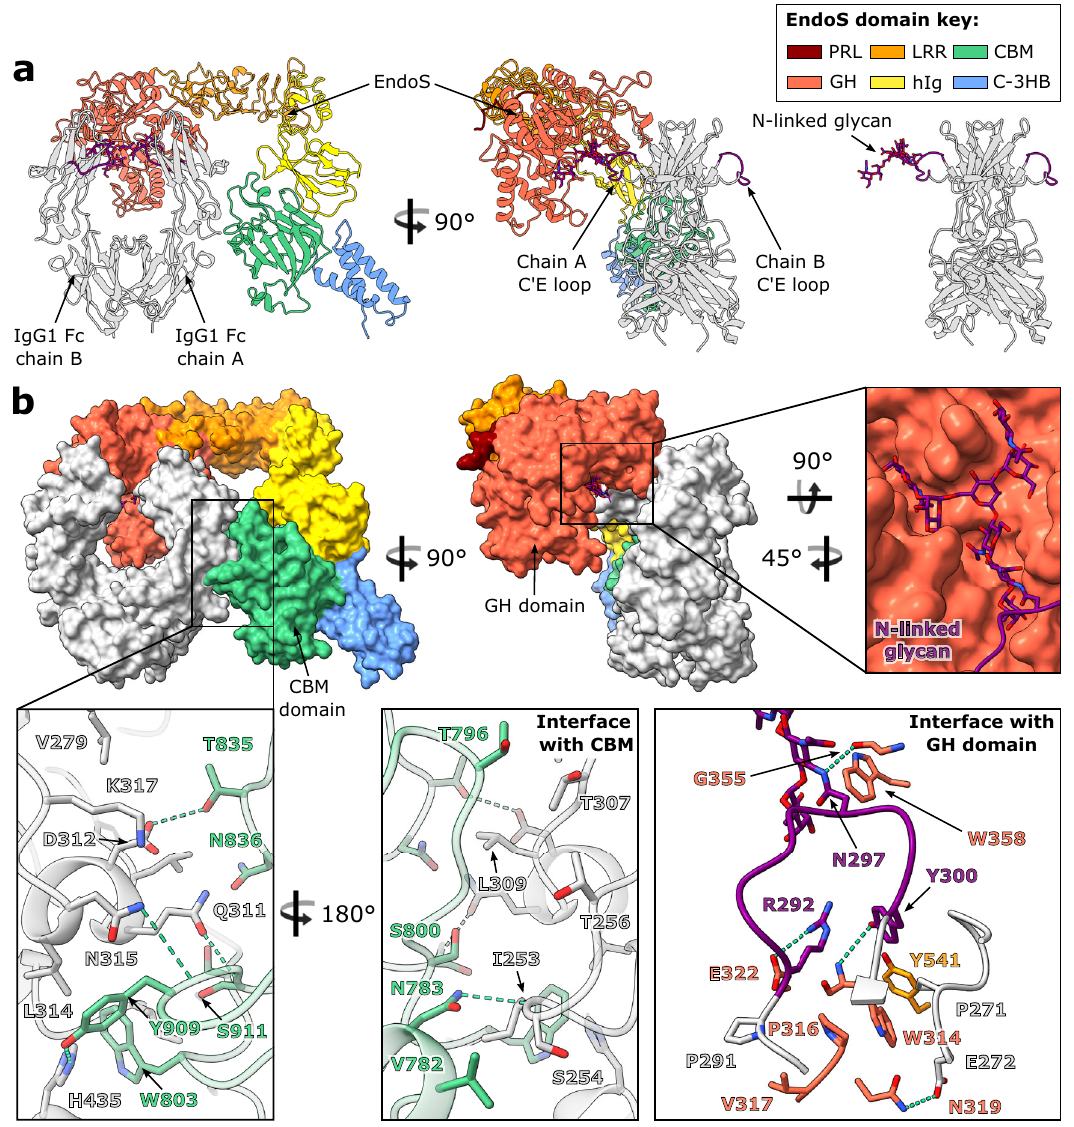
Fig. 4 | Crystal structure of EndoS D233A/E235L -IgG1 Fc E382R complex. a Overall structureofcomplexdepictedasacartoon.IgG1Fc E382R iscolouredsilver,withitsC ′ E loops coloured purple; the N-linked glycan is shown as sticks and coloured by heteroatom (oxygen in red and nitrogen in blue). EndoS domains are coloured as follows: proline-rich loop (PRL), maroon; glycosidase domain (GH), red; leucine- rich repeat domain (LRR), orange; hybrid Ig domain (hIg), yellow; carbohydrate-